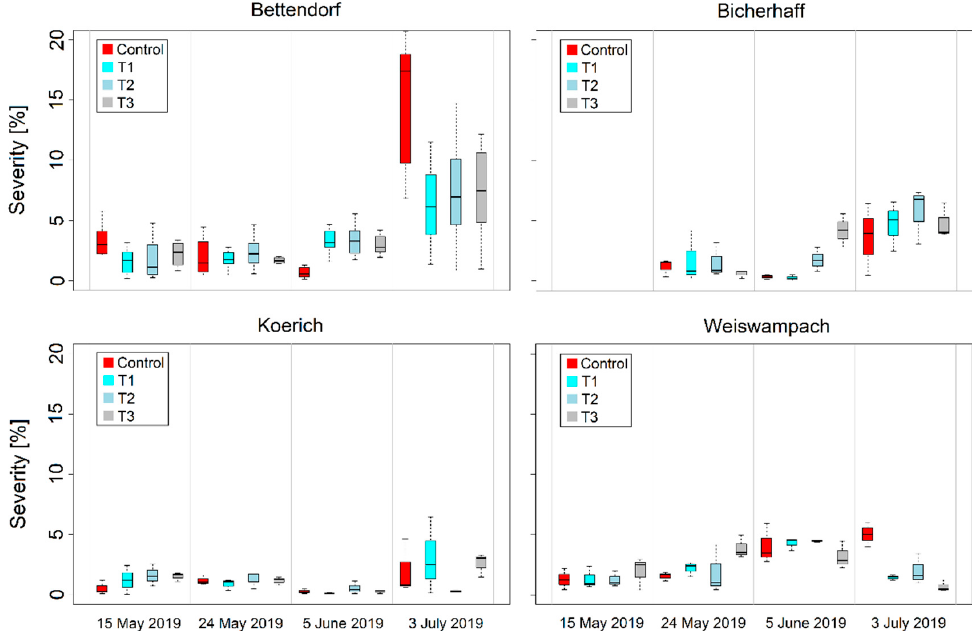
Figure 5. Variations of the Red-Green-Blue (RGB) imagery-based estimates of wheat leaf rust (WLR) during the monitoring period in 2019 at the experimental sites in the Grand-Duchy of Luxembourg. T1, T2, and T3 refer to single, double, and triple fungicide-treated plots (Table 1); Control refers to the non-fungicide treated plots. The horizontal line represents the median value, surrounded by box edges presenting the 25th and 75th percentiles. The whiskers are the two lines outside of the box that extend to the highest and lowest data values. No data is available at Bicherhaff on 15 May 2019 since the images were blurry due to high velocity wind during the unmanned aerial vehicle flight.